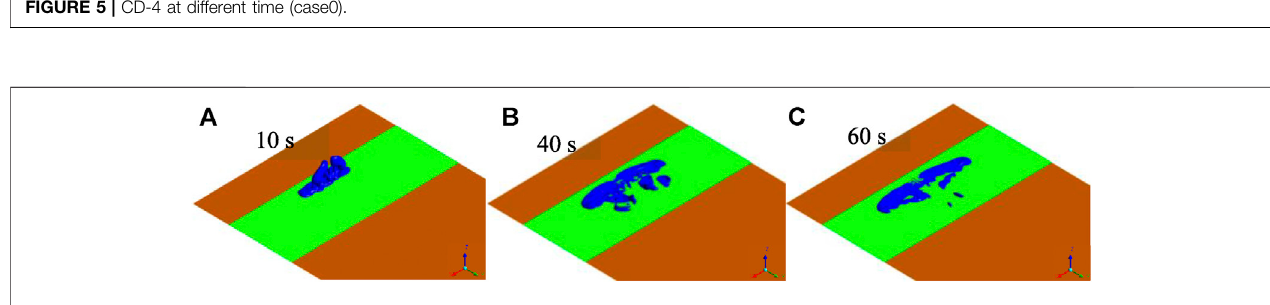
FIGURE 5 | CD-4 at different time (case0).